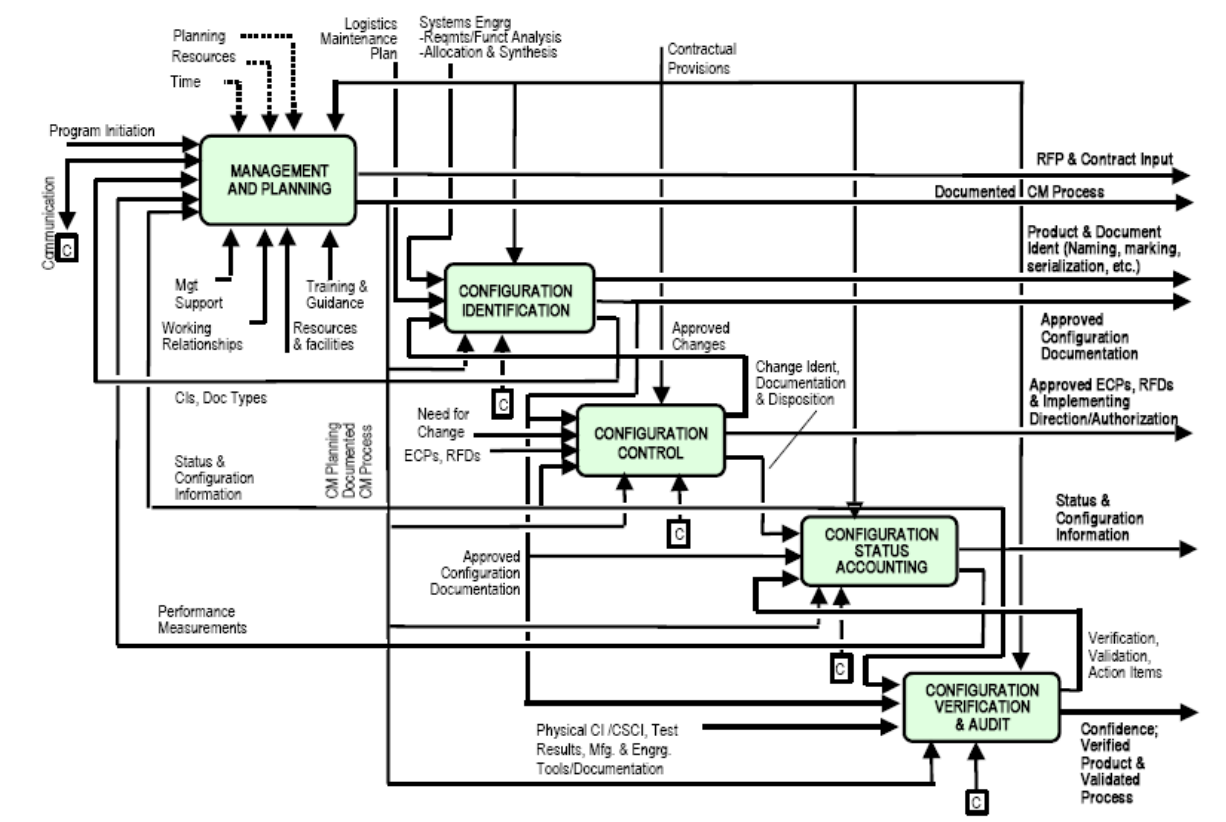
Figure 1. Configuration management functions (Mil-HDBK-61B